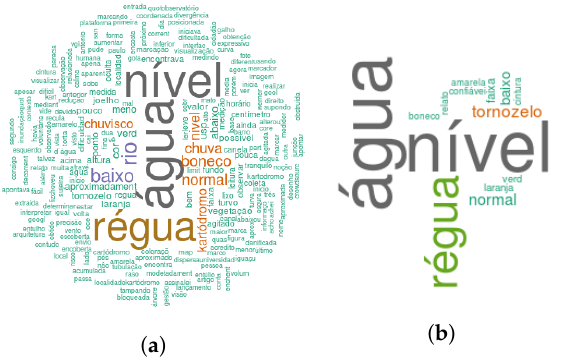
Figure 20. Citizen Observations Description and Category Synthesis. ( a ) Citizen Observations Description WordCloud; ( b ) Citizen Observations Category WordCloud.